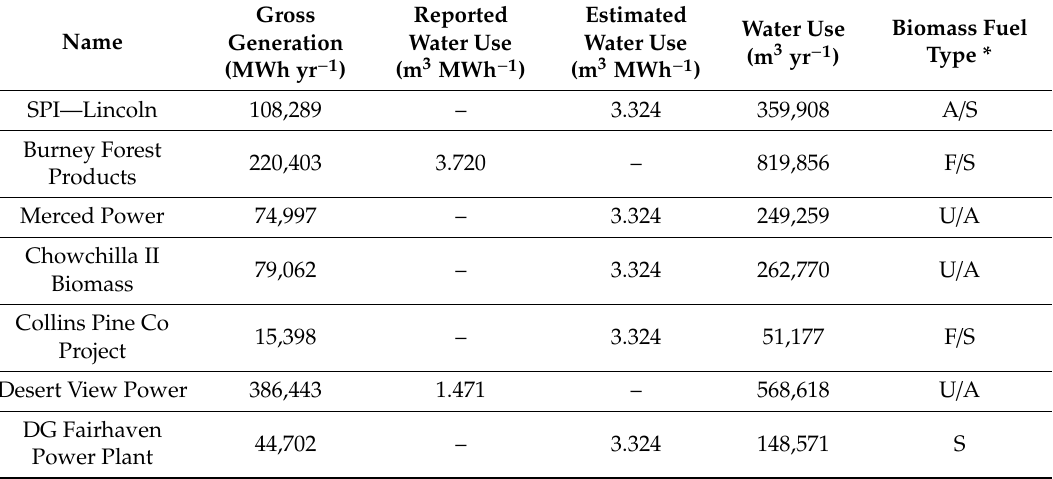
Table A1. Biomass power plant